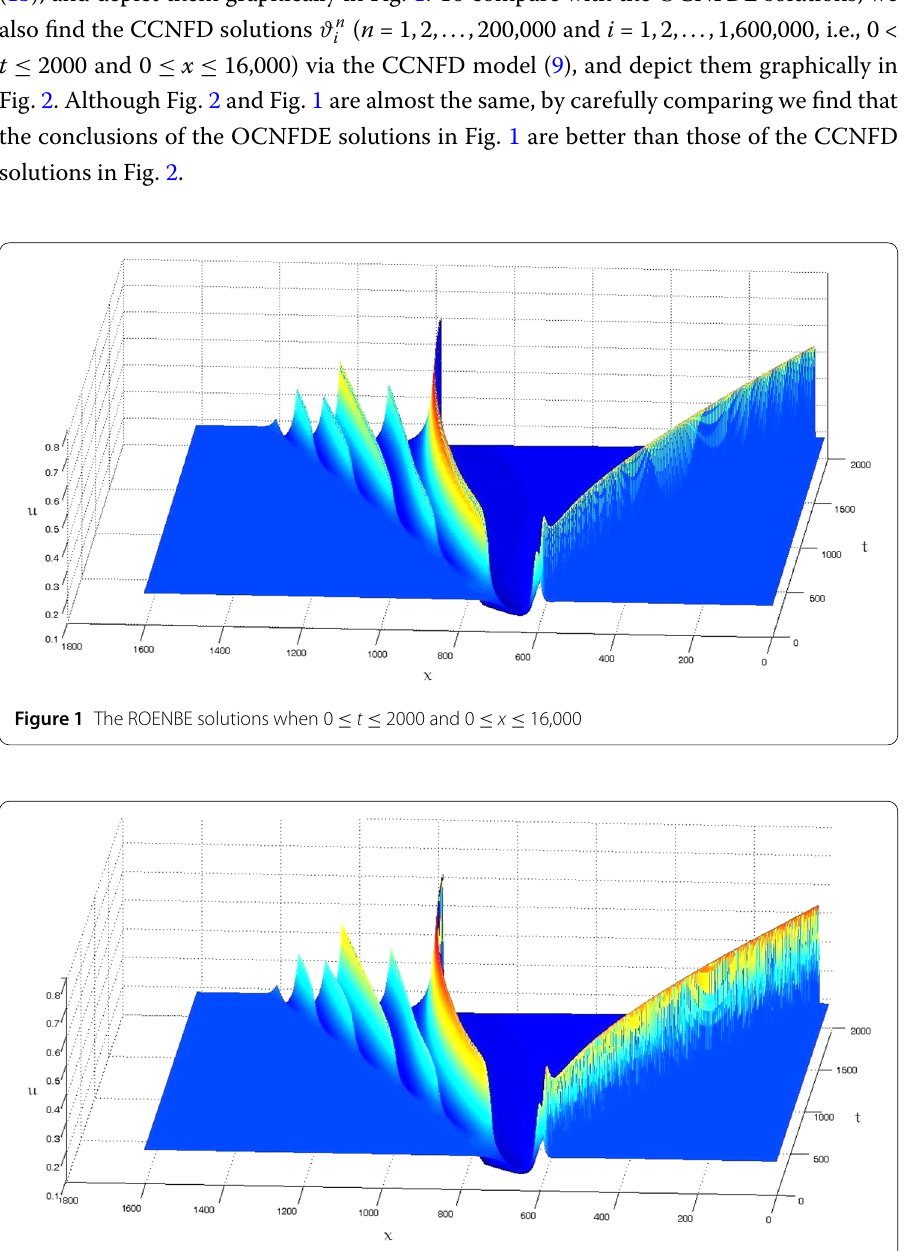
Figure 2 The CCNFD solutions when 0 ≤ t ≤ 2000 and 0 ≤ x ≤